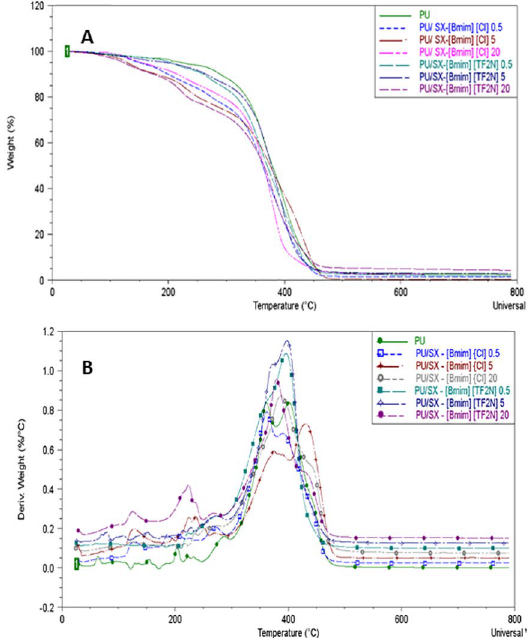
Figure 5. PU and PU composites: a) TG and b) DTG thermograms. Table 2. TGA and DSC data for PU and PU composites